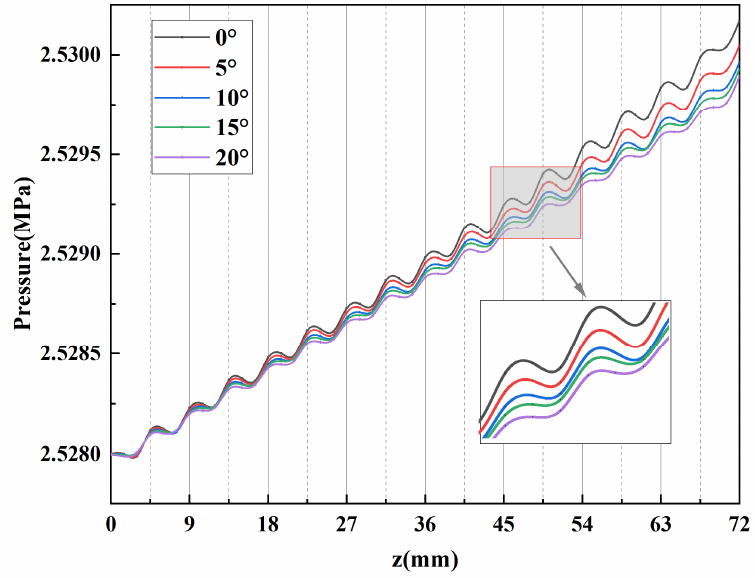
Figure 12. Relationship between the hot side pressure drop and angle θ of spiral